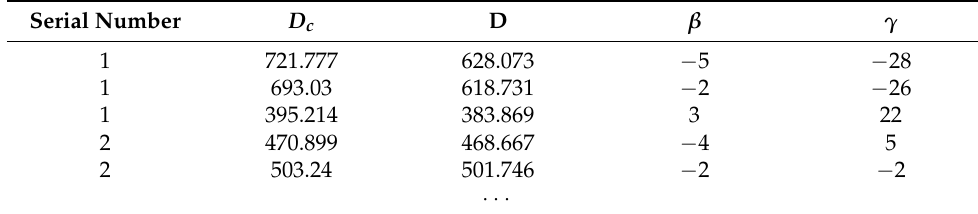
Table 3. Parameters of sample